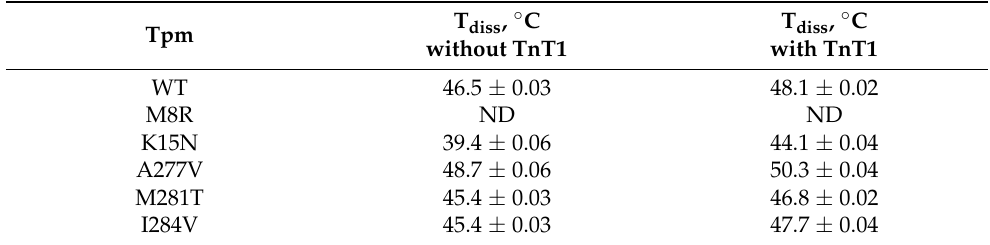
Table 1. Thermal stability of Tpm–F-actin complexes in the presence or absence of TnT1 fragment.